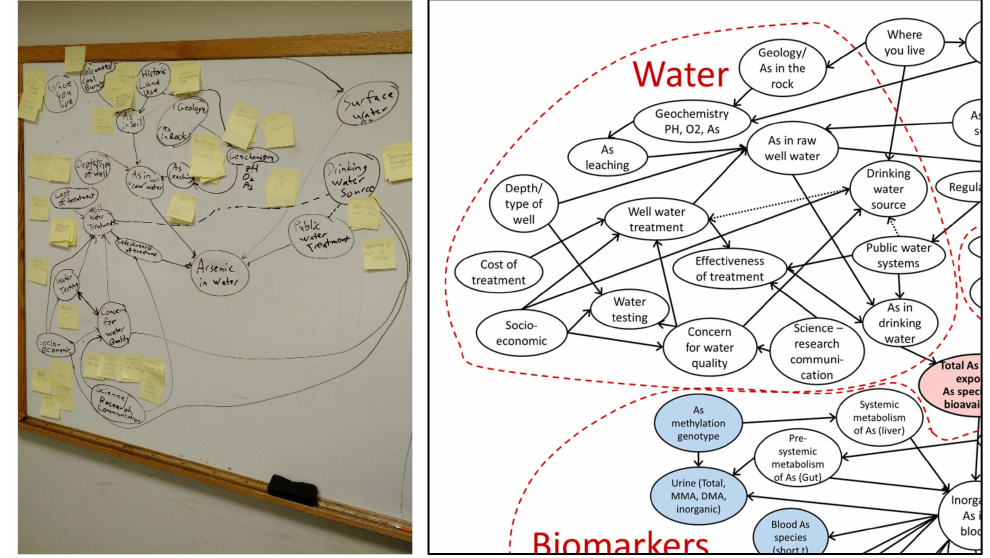
Figure 2. Brainstorming and sticky notes become a detailed mental model. The representation on the right is not meant to be read node by node, but rather to show the type of graphical model that results from the assembly process ( left